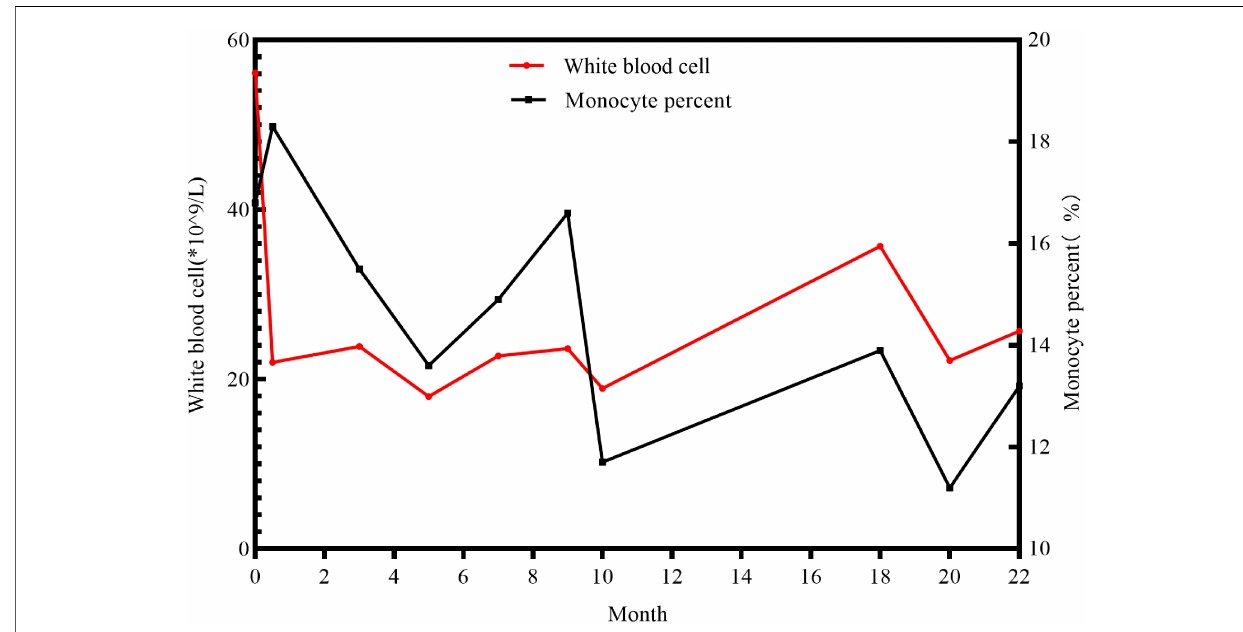
FIGURE 1 The longitude data of white blood cells and monocyte percent of the